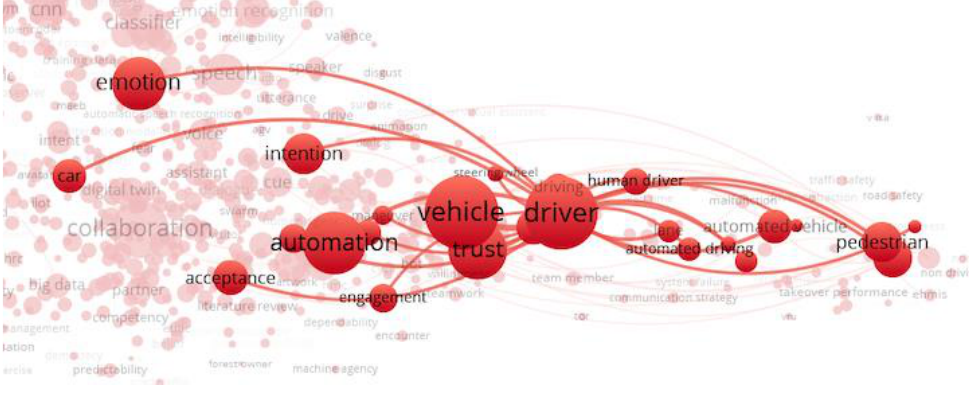
Figure 13. Vehicle dependency.